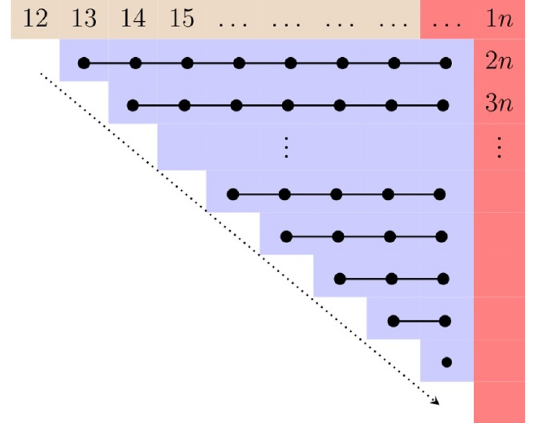
Here, integrals over elements of the index V (shown in blue) are indicated with black comb dots. Integrals over all black dots connected via links are performed simultaneously by an application of (4.35), while the dotted arrow shows the order in which the contour integrals over the disconnected chains of dots are